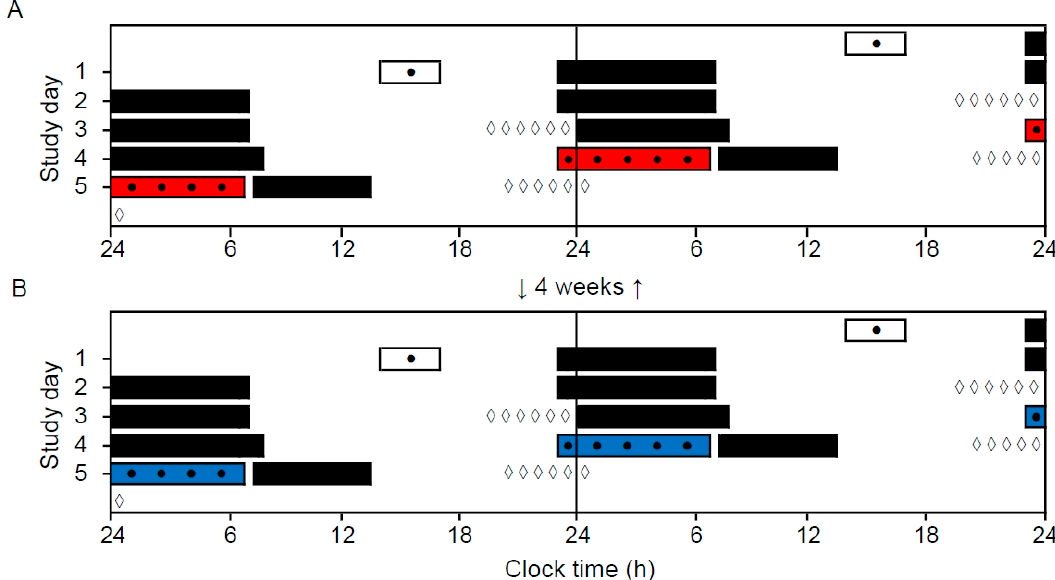
Figure 1. Double-raster plot of the simulated night shift protocol. The protocol included two simulated night shifts (from 23:00 to 06:45 h) performed in a laboratory with long-wavelength narrow-bandwidth light ( A ) and short-wavelength narrow-bandwidth light ( B ). The night shifts were separated by 4 weeks and the order of conditions was counterbalanced. White bars indicate enrollment and practice session (before the first night shift only) in the laboratory. Black bars indicate assumed sleep periods at home. Colored bars indicate night shifts in the laboratory. Black dots indicate primary test bouts including the Positive and Negative A ff ect Schedule (PANAS), the Karolinska Sleepiness Scale (KSS), a Psychomotor Vigilance Task (PVT), and a Digit Symbol Substitution Test (DSST). White diamonds indicate salivary dim-light melatonin sampling at home.